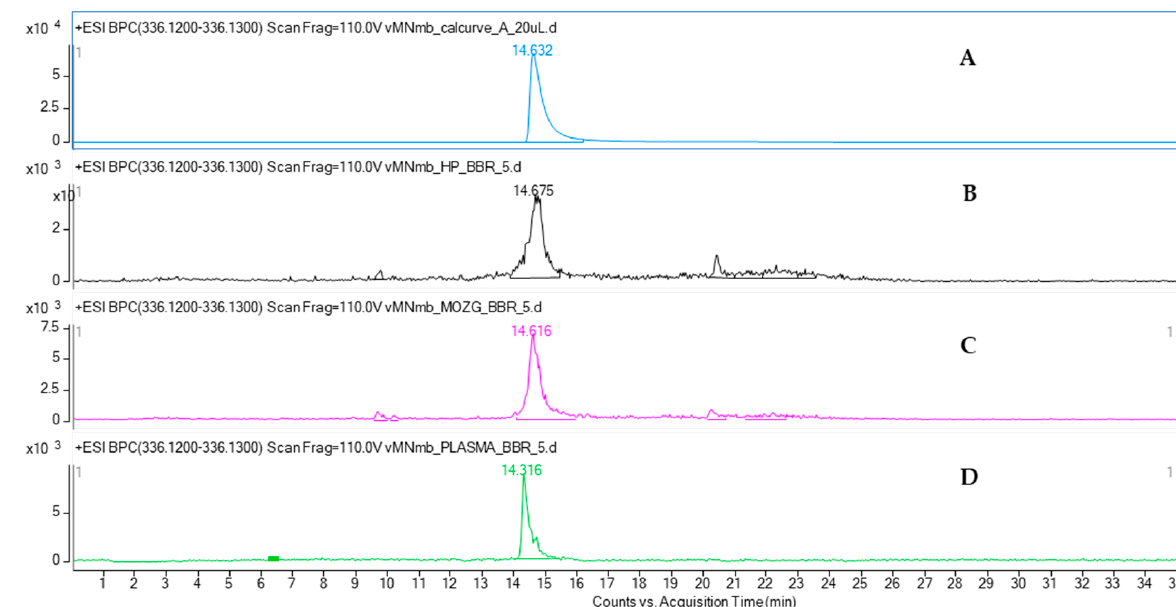
Figure 6. Total ion chromatogram of berberine standard ( A ) and the extracted ion chromatograms (EIC) of berberine peak in the hippocampus ( B ), brain ( C ), and plasma ( D ), recorded in the positive ionization mode.